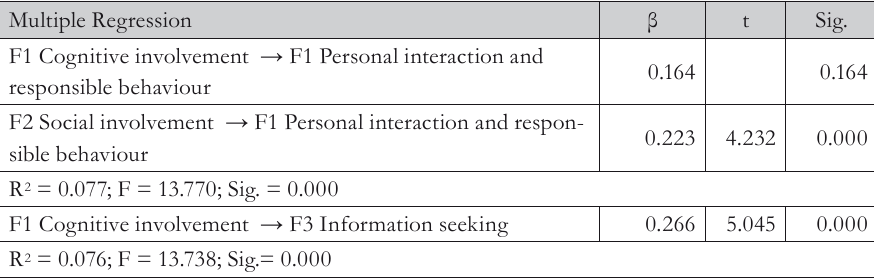
Tab. 2 – Relationship between involvement and customers’ participation behaviour